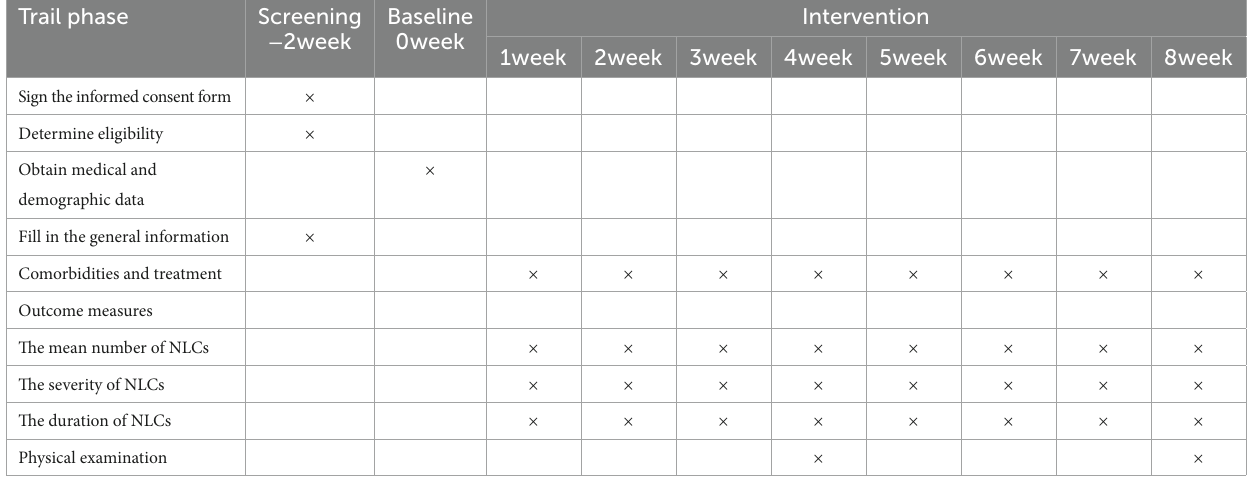
TABLE 1 Study evaluation procedures and timeline. Trail